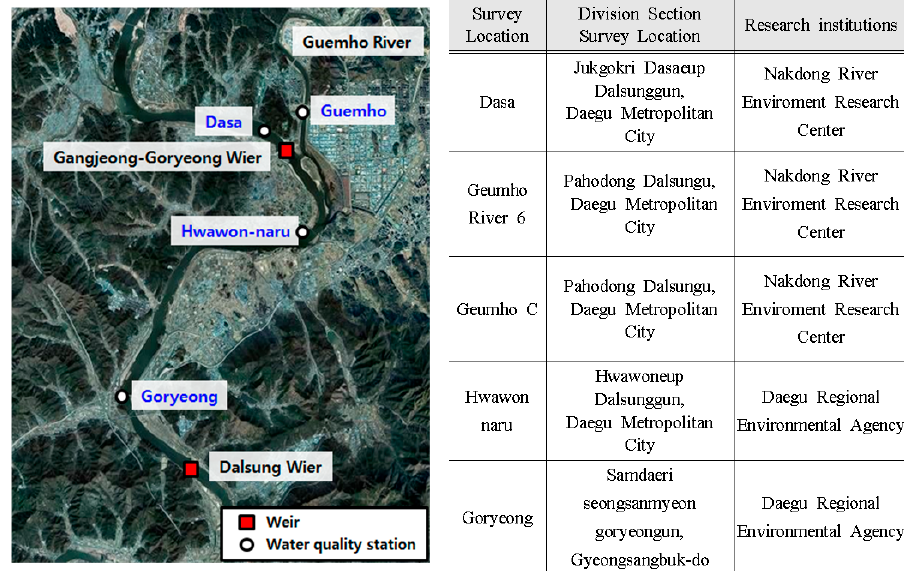
Figure 4. Survey Location of Water Quality Gangjeong-Goryeong Weir and Dalseong Weir Section .